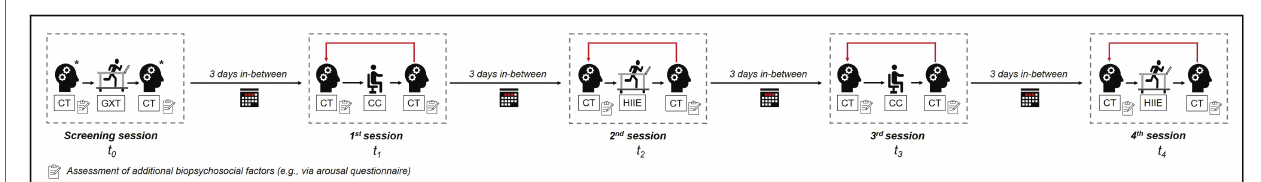
FIGURE 2 | Schematic illustration of the study design “within-subject repeated (double) crossover design with pre-post-test comparisons” recommended to investigate the effects of an acute bout of physical exercises on cognitive performance. Please note that the order of the exercise and control conditions should be randomized. To investigate, for example, the effects of exercise intensity (high intensity vs. moderate intensity), two additional sessions would have to be added. In this context, we recommend to compare high-intensity interval exercise (HIIE) with moderate-intensity interval exercise (MIIE). If it is aimed to receive more details in regard to the relationship between the amount of exercise intensity and cognition (e.g., U-shaped relationship), at least three exercise intensities should be compared (e.g., light-, moderate-, and high-intensity interval exercise). The sessions t0, t1, t2, and t3, and t4 are separated each by 3 days (note: the relatively short duration between the sessions allows a standardization of the menstrual cycle phase for female participants with the inclusion of 4–5 sessions in the follicular phase and still ensure a sufficiently long period for recovery after e.g., high-intensity physical exercise; Elliott-Sale et al., 2021). *indicates that cognitive testing during the initial session can be used to adequately habituate participants with the cognitive tests and testing protocol. CT, cognitive testing; CC, control condition; GXT, graded exercise test (e.g., running on a treadmill); HIIE, high-intensity interval exercise (i.e.,